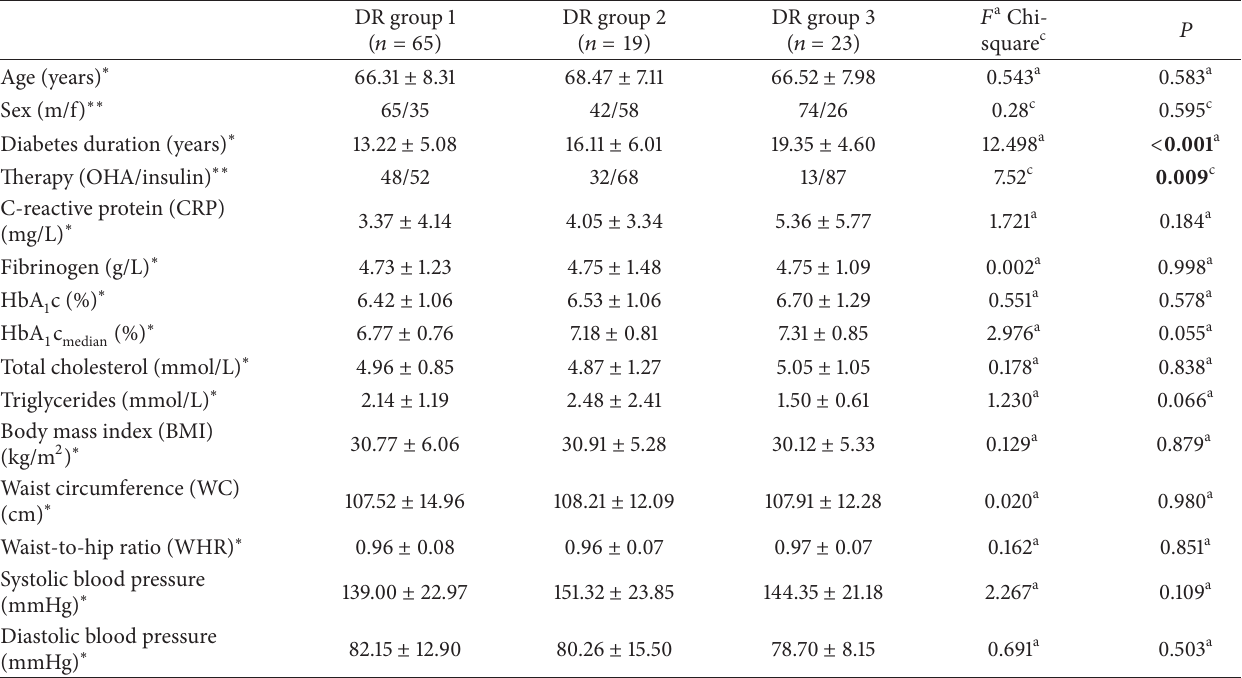
Table 2: Basic characteristics, inflammatory and haemostatic markers, other markers of endothelial dysfunction, and anthropometric and clinical parameters of type 2 diabetic patients ( 𝑛 = 107 ) divided into three groups according to the diabetic retinopathy